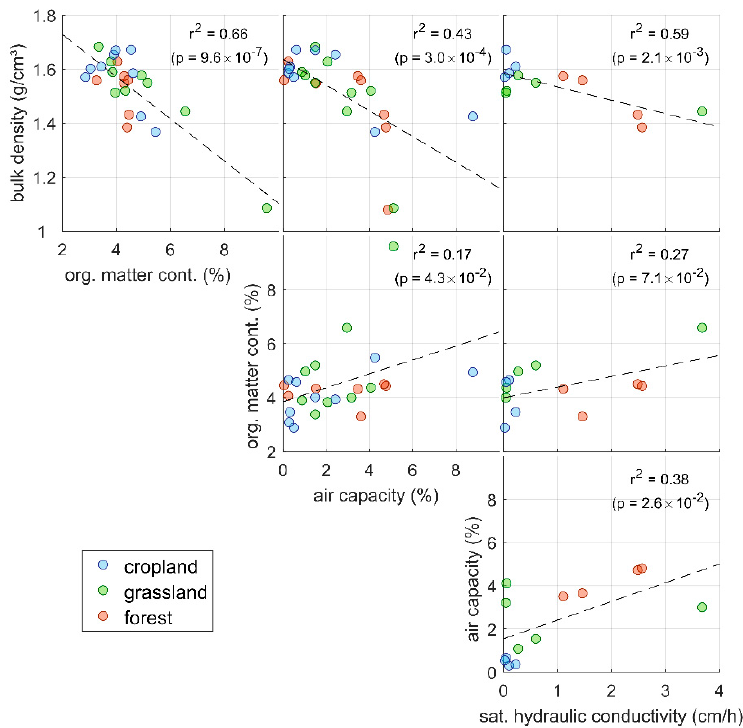
Figure 4. Dependencies between the soil properties bulk density, org. matter content, air capacity and saturated hydraulic conductivity separated by land use type.